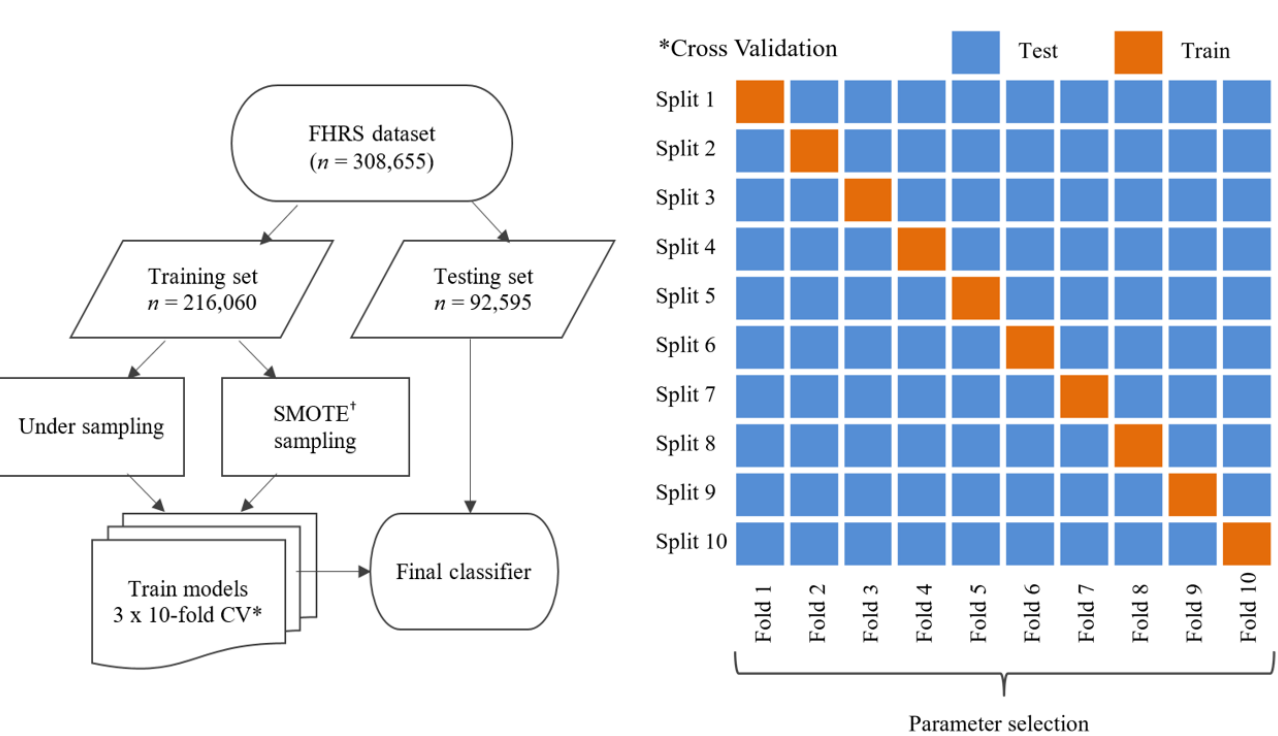
Figure 1. An overview of the analysis process. The full FHRS dataset is split into training and testing phases prior to SMOTE and under-sampling. † Synthetic minority oversampling technique. * Cross-validation.